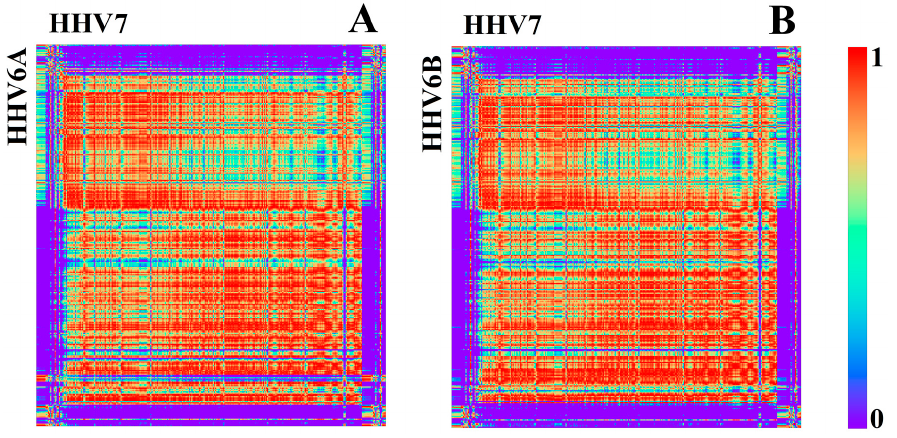
Figure 10. Correlation heatmap between HHV6A with HHV7 ( A ) and HHV6B with HHV7 ( B ) based on k = 1 (bin width 500 bp).